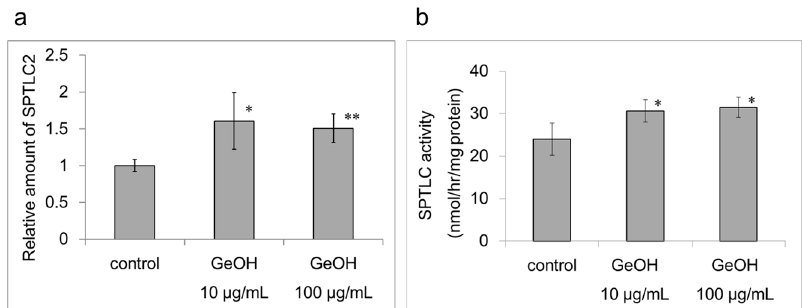
Figure 8. Effect of GeOH on serine palmitoyltransferase (SPTLC) levels and activity in cultured epidermal keratinocytes. HaCaT cells were cultured for 3 days in medium supplemented with 10 or 100 μ g/mL GeOH. ( a ) Subsequently, Western blotting was performed using anti-SPTLC2 and anti-